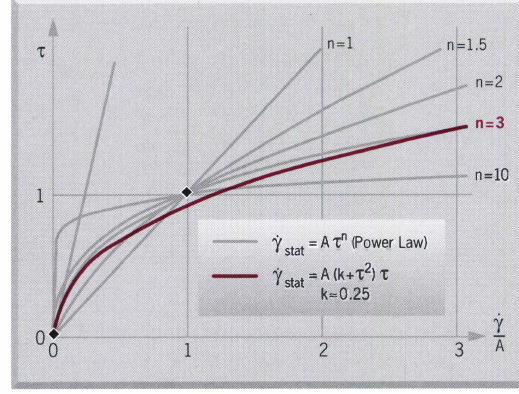
Fig. 7: Cold polar glaciers (so-called Piedmont glaciers) on the island Axel Heiberg in the